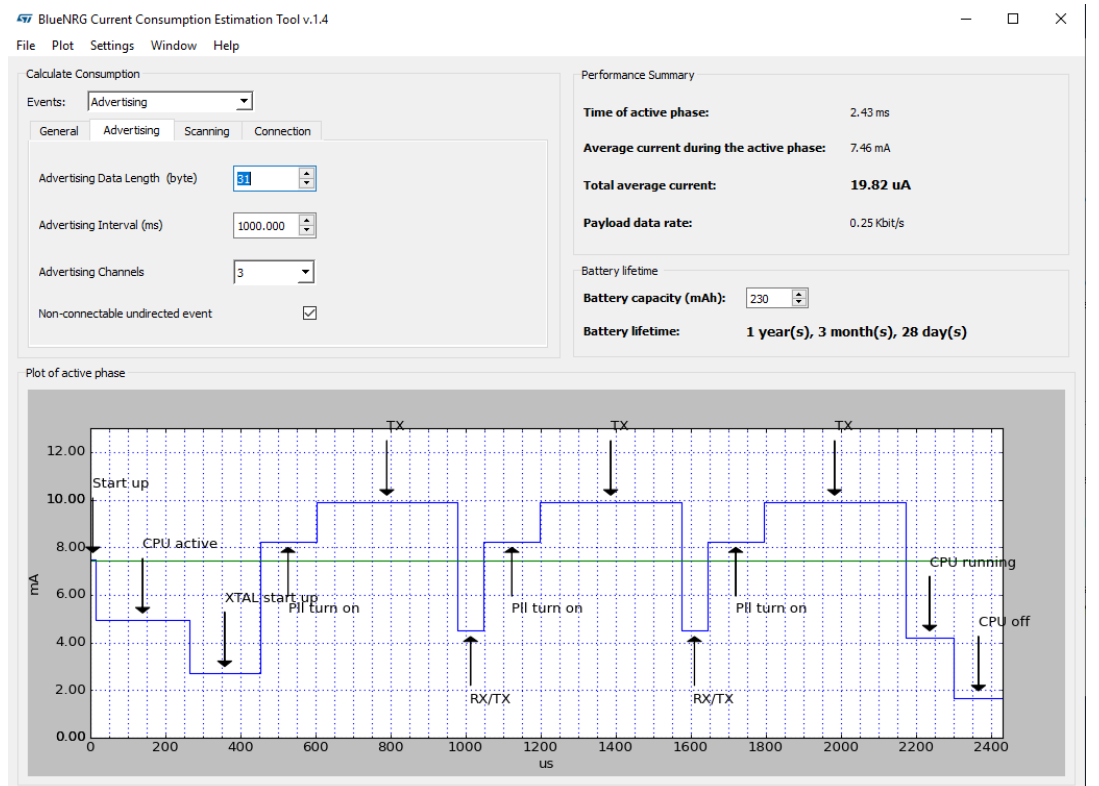
Figure 3. Bluetooth Low Energy (BLE) current